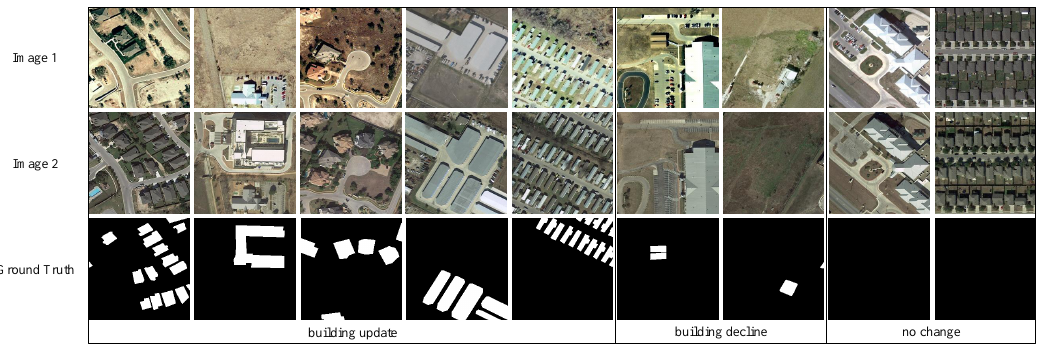
Figure 4. Selected cropped samples (256 × 256) from LEVIR-CD. Each column represents one sample, including the image pair (row 1 and 2), and the label (the last row, white denotes change, black means no change). Columns 1–5 show the building update; 6 and 7 show the building decline; and the last two columns display samples of no change.